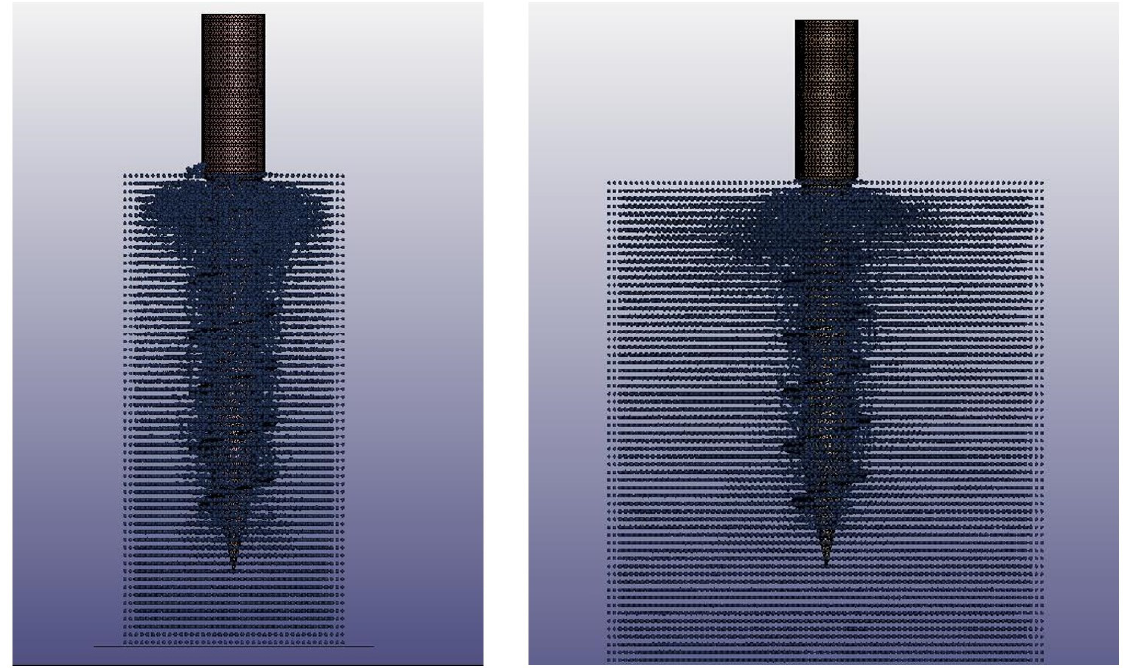
Figure 7. The range of soil disturbance for different soil models after the installation of the screw pile.